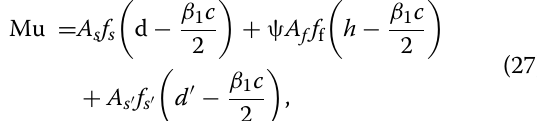
compute the flexural moment and failure loads of